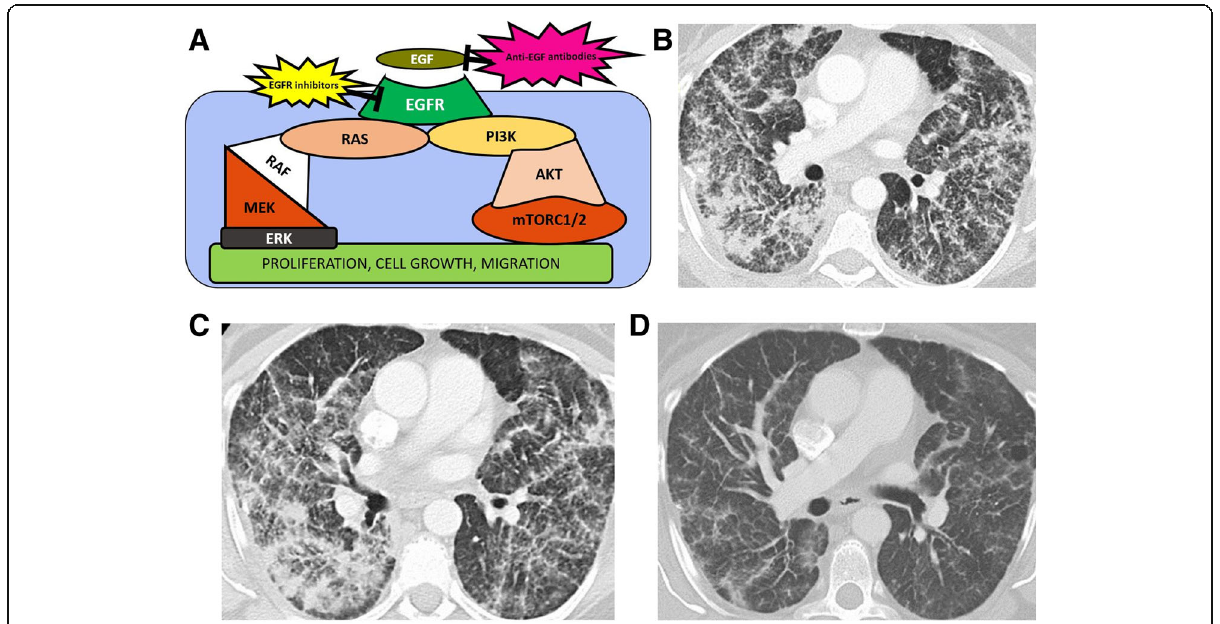
Fig. 3 RTK-RAS pathway. a Image showing the RAS-RTK pathway, activated by epithelial growth factor (EGF) and its receptor (EGFR). RAS and EGF/EGFR activate PI3K-RAS-mTORC and RAS-RAF-MEK pathways, determining cell proliferation and cell growth. The pathway is blocked by EGF antibodies, such as cetuximab or EGFR inhibitors such as erlotinib or afatinib ( b – d ) contrast-enhanced CT images of the chest 64-year-old woman with multifocal adenocarcinoma of the lung with mutation of the EGFR exon 21. Patient was initially treated with erlotinib and follow up CT ( b ) at 2 months after treatment was started shows mild improvement of the lung consolidative opacities compared to baseline CT of the chest ( a ). Patient developed erlotinib associated shortness of breath and rash, and was switched to another EGFR inhibitor, afatinib. c CT of the chest performed 6 months after afatinib was started, shows significant resolution of the consolidations and of the interlobular